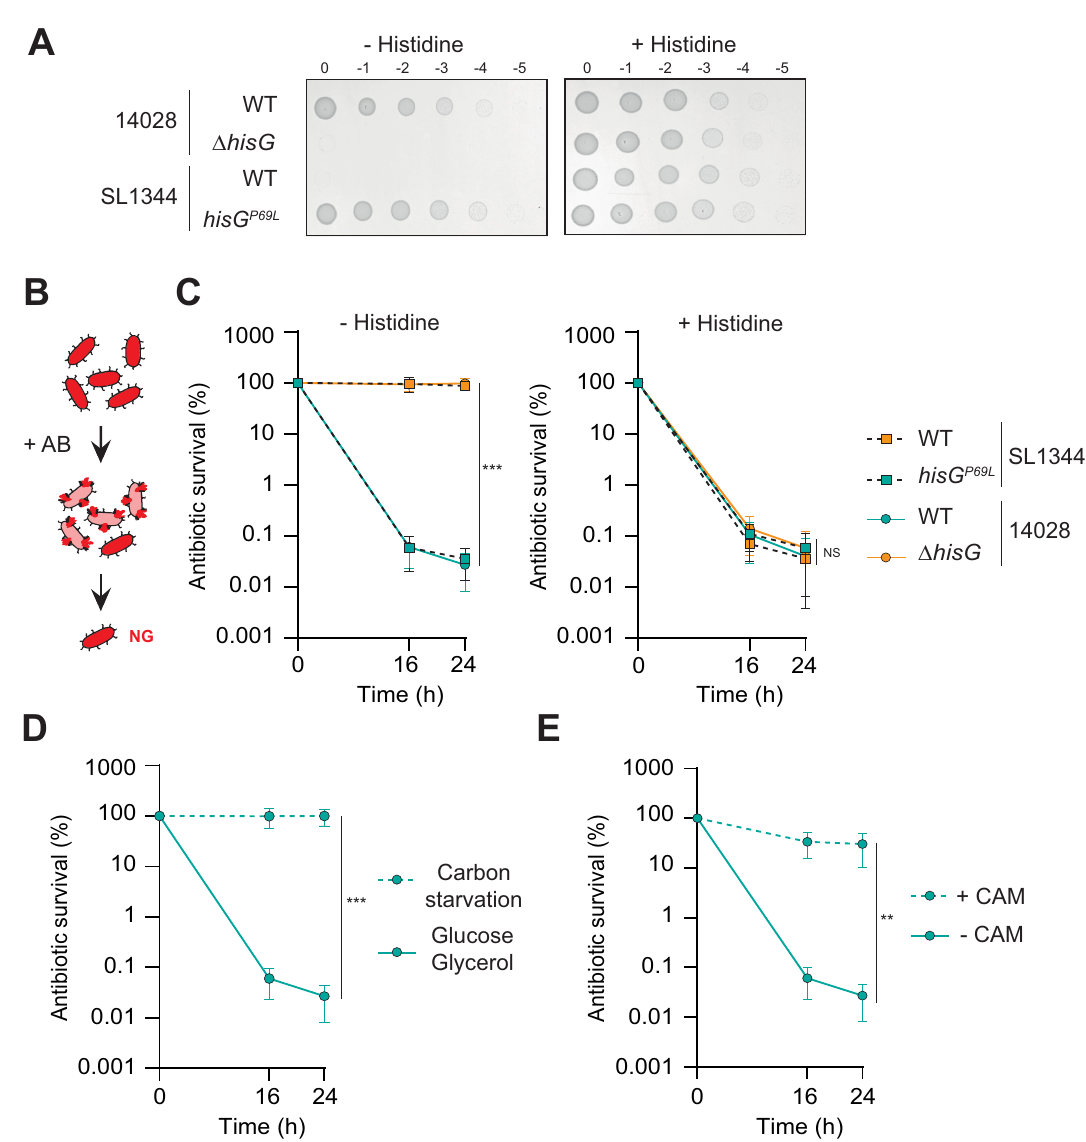
Fig 1. Genetic and/or environmental factors can lead to antibiotic tolerance in laboratory medium. ( A ) Growth of WT and Δ hisG 14028 and WT and hisG P69L SL1344 Salmonella . Ten-fold dilution series were spotted on minimal medium plates in the absence (left) or presence (right) of histidine. ( B ) Illustration of the in vitro antibiotic survival assay where growers (pink) are killed by cefotaxime and non-growers (red) survive. ( C ) CFU enumeration of survival of WT and hisG P69L SL1344 Salmonella as well as WT and Δ hisG 14028 Salmonella exposed to cefotaxime treatment in M9GG in absence (left) or presence (right) of histidine. Data from the 24 h timepoint were compared using one way ANOVA with Tukey’s multiple-comparison test, ��� p < 0.001; NS, not significant. ( D ) CFU enumeration of survival of WT 14028 exposed to cefotaxime in minimal medium supplemented with carbon sources (Glucose/ Glycerol) or not (carbon starvation). ( E ) CFU enumeration of survival of WT 14028 exposed to cefotaxime in M9GG medium in the presence or absence of chloramphenicol (CAM). ( D-E ) Statistical significant differences by two-sided t -test between the 24 h timepoint are indicated as �� p < 0.01; NS, not significant. Panels C-E , data represent the mean and standard deviation (SD) of at least three biological repeats. Of note, WT data are the same on panel D and E as all experiments were conducted in parallel. Auxotrophic strains are depicted in orange, prototrophic in turquoise.